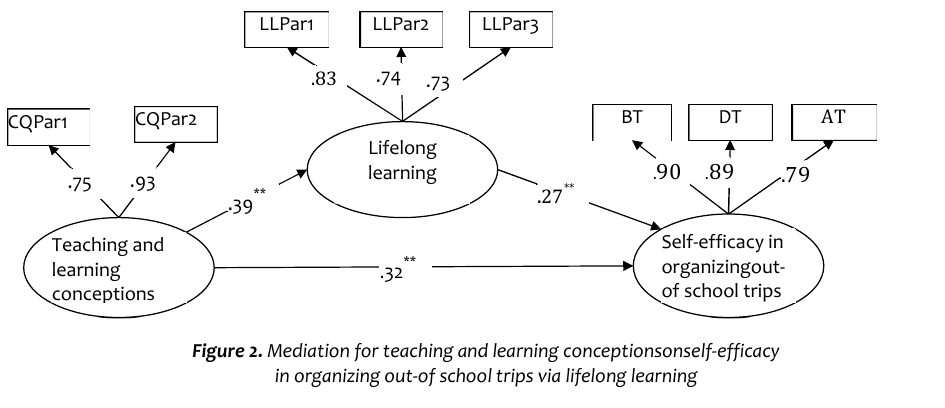
Figure 2. Mediation for teaching and learning conceptionsonself-efficacy in organizing out-of school trips via lifelong